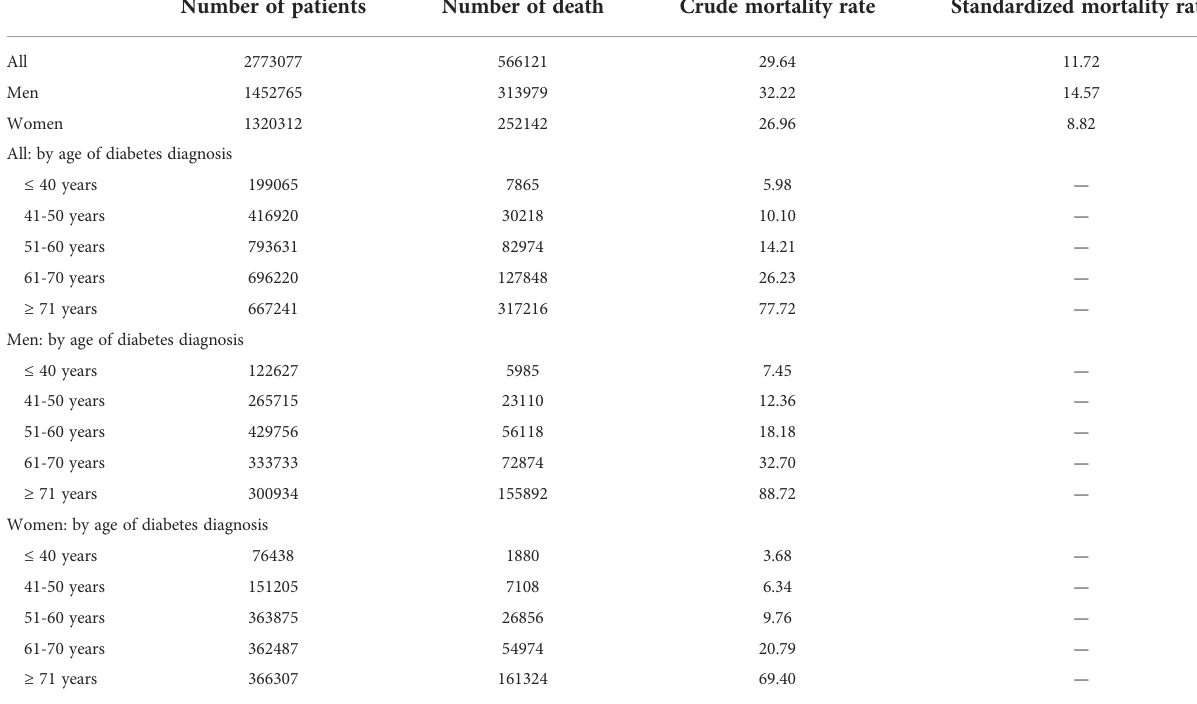
TABLE 1 All-cause mortality rates in patients with diabetes between 2007 and 2017 (follow up to the end of 2018). Number of patients Number of death Crude mortality rate Standardized mortality